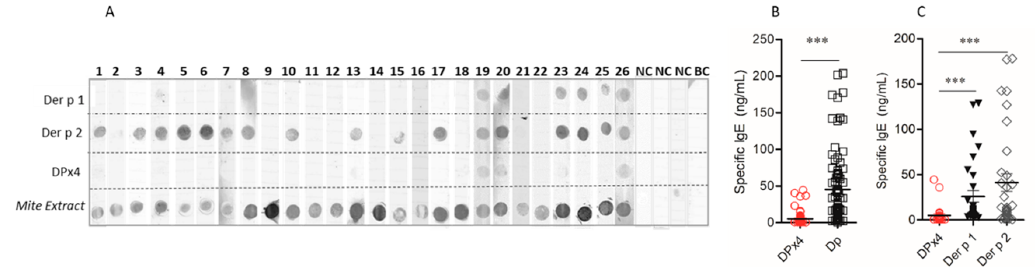
Figure 3. Serum IgE levels as detected by ELISA. ( A ) Non-denaturing dot blot showing the IgE reactivity of sera from 26 allergic patients (lanes 1–26), three non-allergic individuals (NC) and buffer alone (BC) in the nitrocellulose blotted proteins. ( B ) IgE reactivity to DPx4 and mite extract in 90 serum samples from allergic patients. ( C ) IgE reactivity to DPx4, Der p 1, and Der p 2 in sera from 32 random-selected allergic patients (*** p < 0.001).